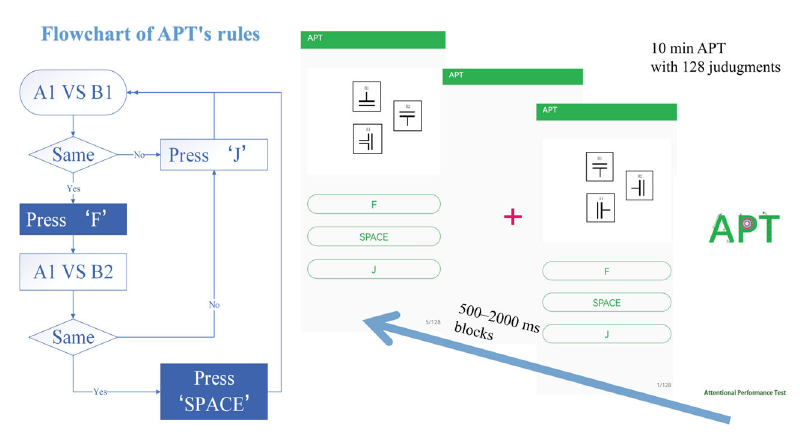
Figure 2. APT rules diagram.